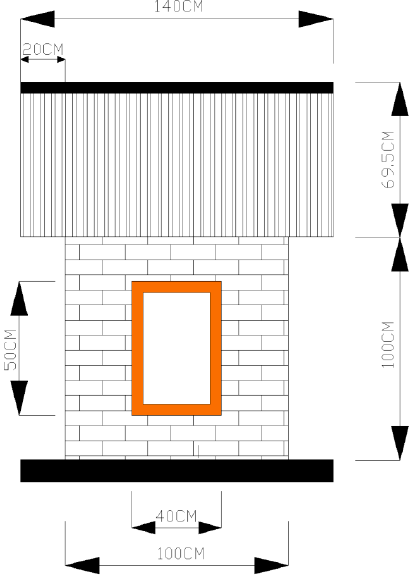
Table 1. Detail of miniature house.